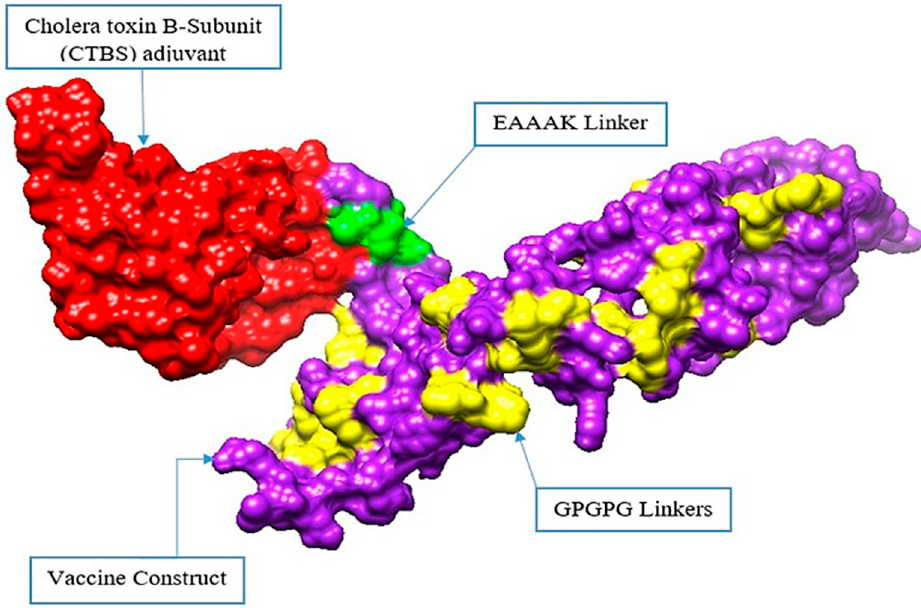
Figure 6. Vaccine structure in 3D. The red color represents the adjuvant (cholera toxin B subunit), the purple color shows the vaccine construct, the green color is for the EAAAK linker, and the yellow color is for the GPGPG linkers.